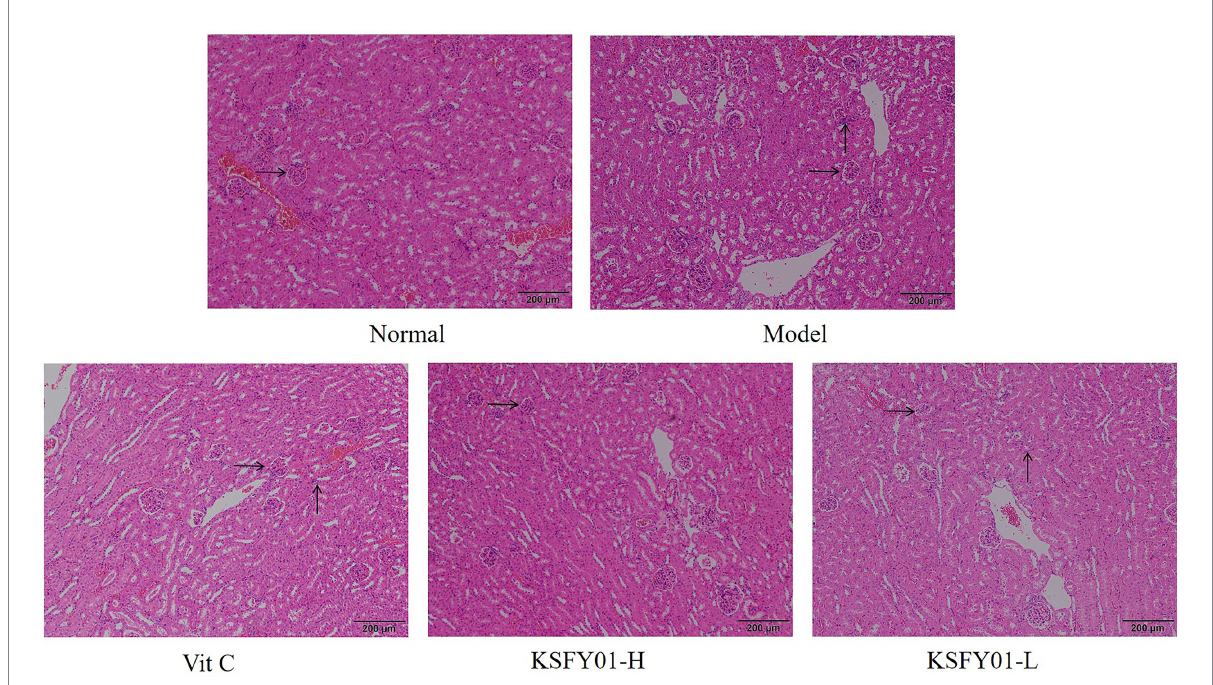
FIGURE 4 H&E pathological observation of kidney tissue in aging mouse (magnification ×100). Vit C, mice treated with vitamin C (200 mg/kg); KSFY01-H, mice treated with L. plantarum KSFY01 (1 × 10 10 CFU/kg); KSFY01-L, mice treated with L. plantarum KSFY01 (1 × 10 9 CFU/kg). → indicate glomerulus; ↑ indicate inflammatory cell in